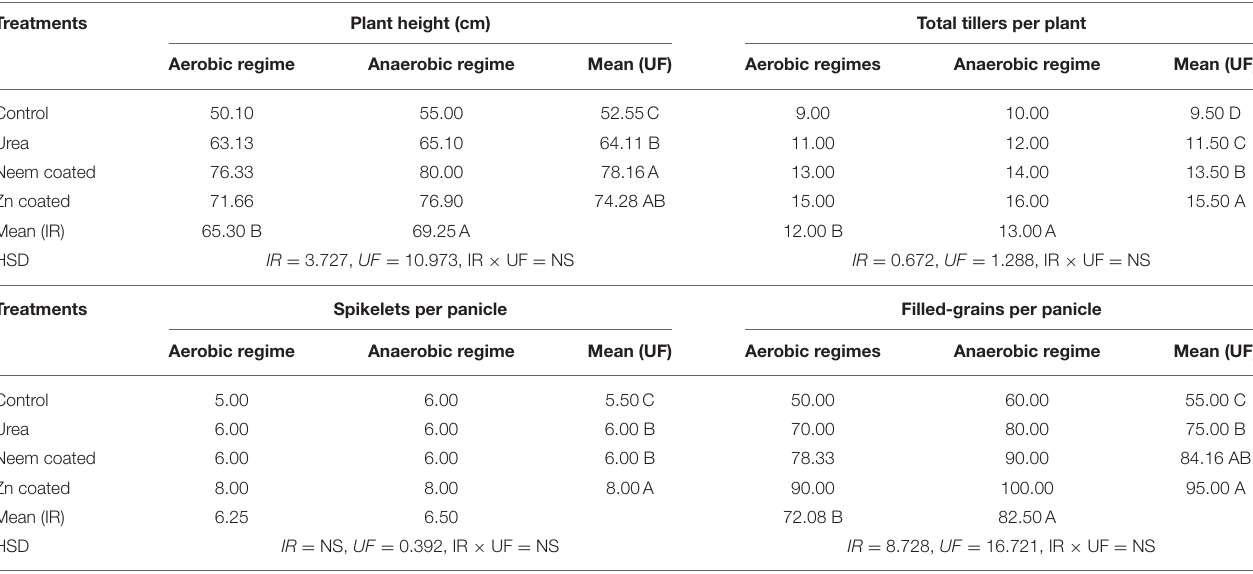
Irrigation regimes (IR)